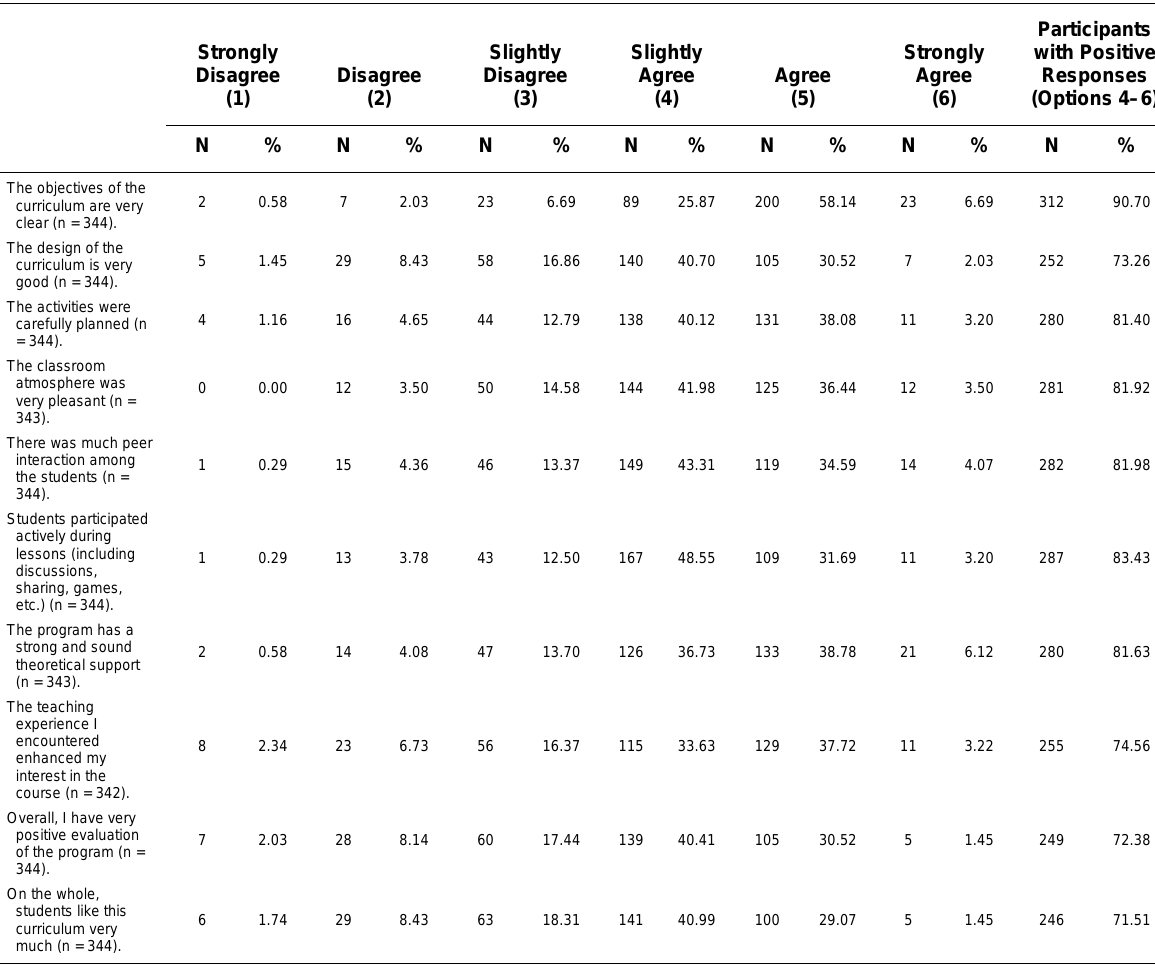
Summary of the Views of the Program